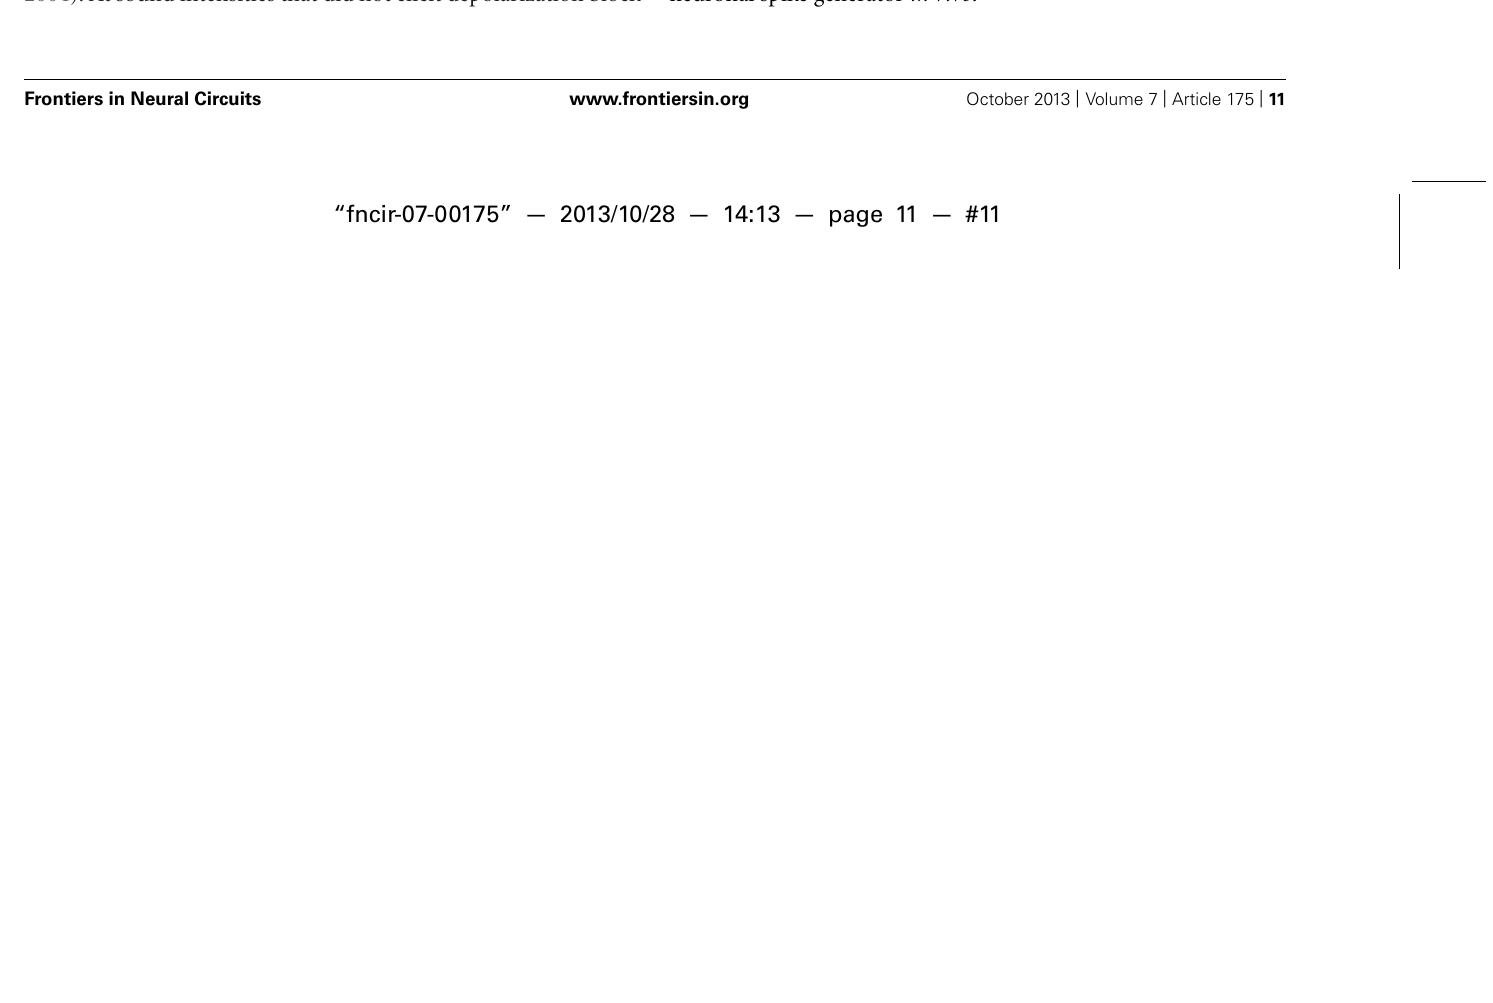
spike heights and widths as a function of two HiDi concentrations. Mean and SD; Comparison between 60 spikes in control and 60 in each concentration of HiDi. Eight neurons. Spike heights: control, 2.5 HiDi: t 119 = 1.01; p = 0.32; control, 4 HiDi: t 119 = 2.56; p = 0.01. Spike widths: control, 2.5 HiDi: t 119 = 1.2; p = 0.23; control, 4 HiDi: t 119 = 3.01; p = 0.003). (D) Strong firing in HiDi does not produce spike loss due to additional depolarization block. Left and right columns show spikes at two intensities. Left: depolarization block at 46 dB SPL is not evident in either Gabazine alone or in HiDi/gabazine (left).The first spike latency in Gabazine alone occurs earlier than in HiDi, suggesting that some of the FSL is due to excitatory local circuits released from inhibition. Firing in HiDi is reduced, leaving the monosynaptic excitatory input. Right: depolarization block at 76 dB SPL is also observed in HiDi/Gabazine. HiDi does not produce additional depolarization block. 100 ms